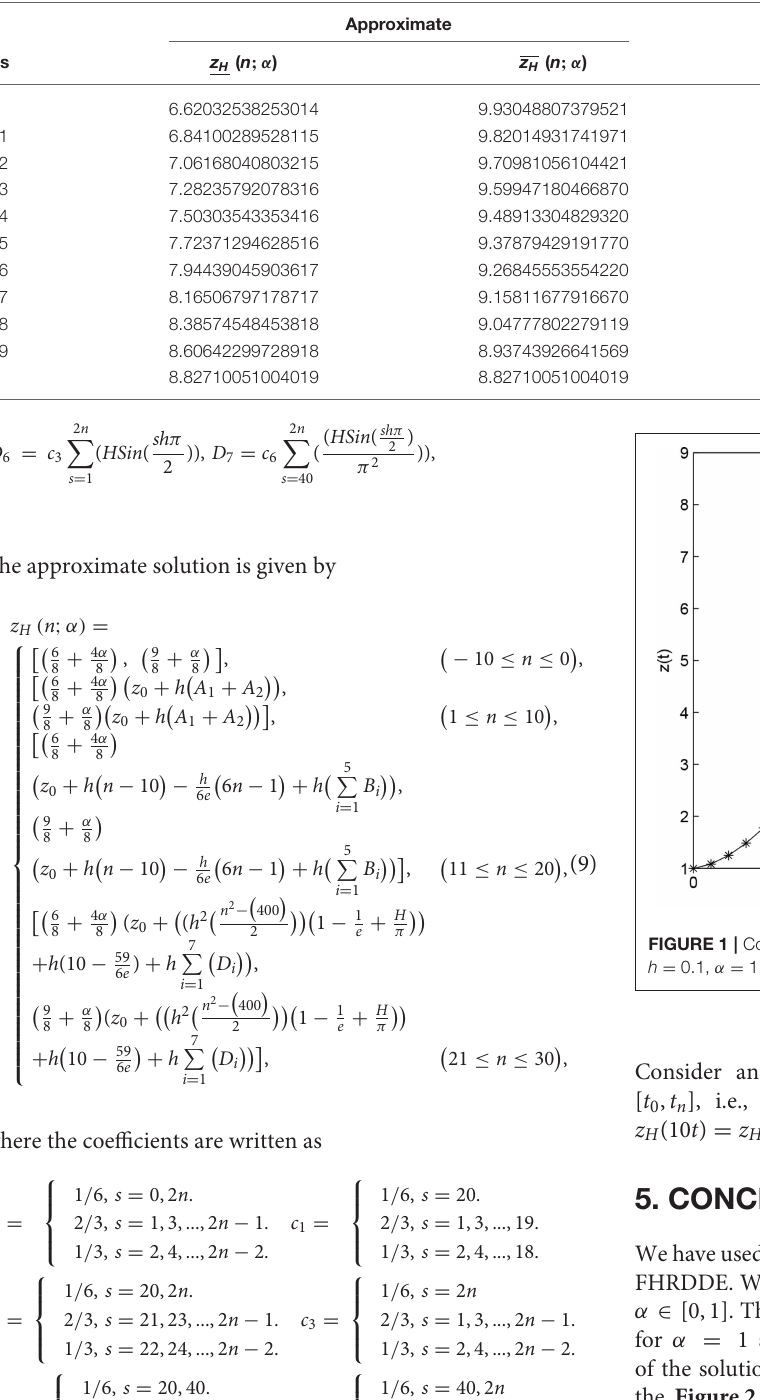
TABLE 1 | Comparing the exact and the approximate solution.